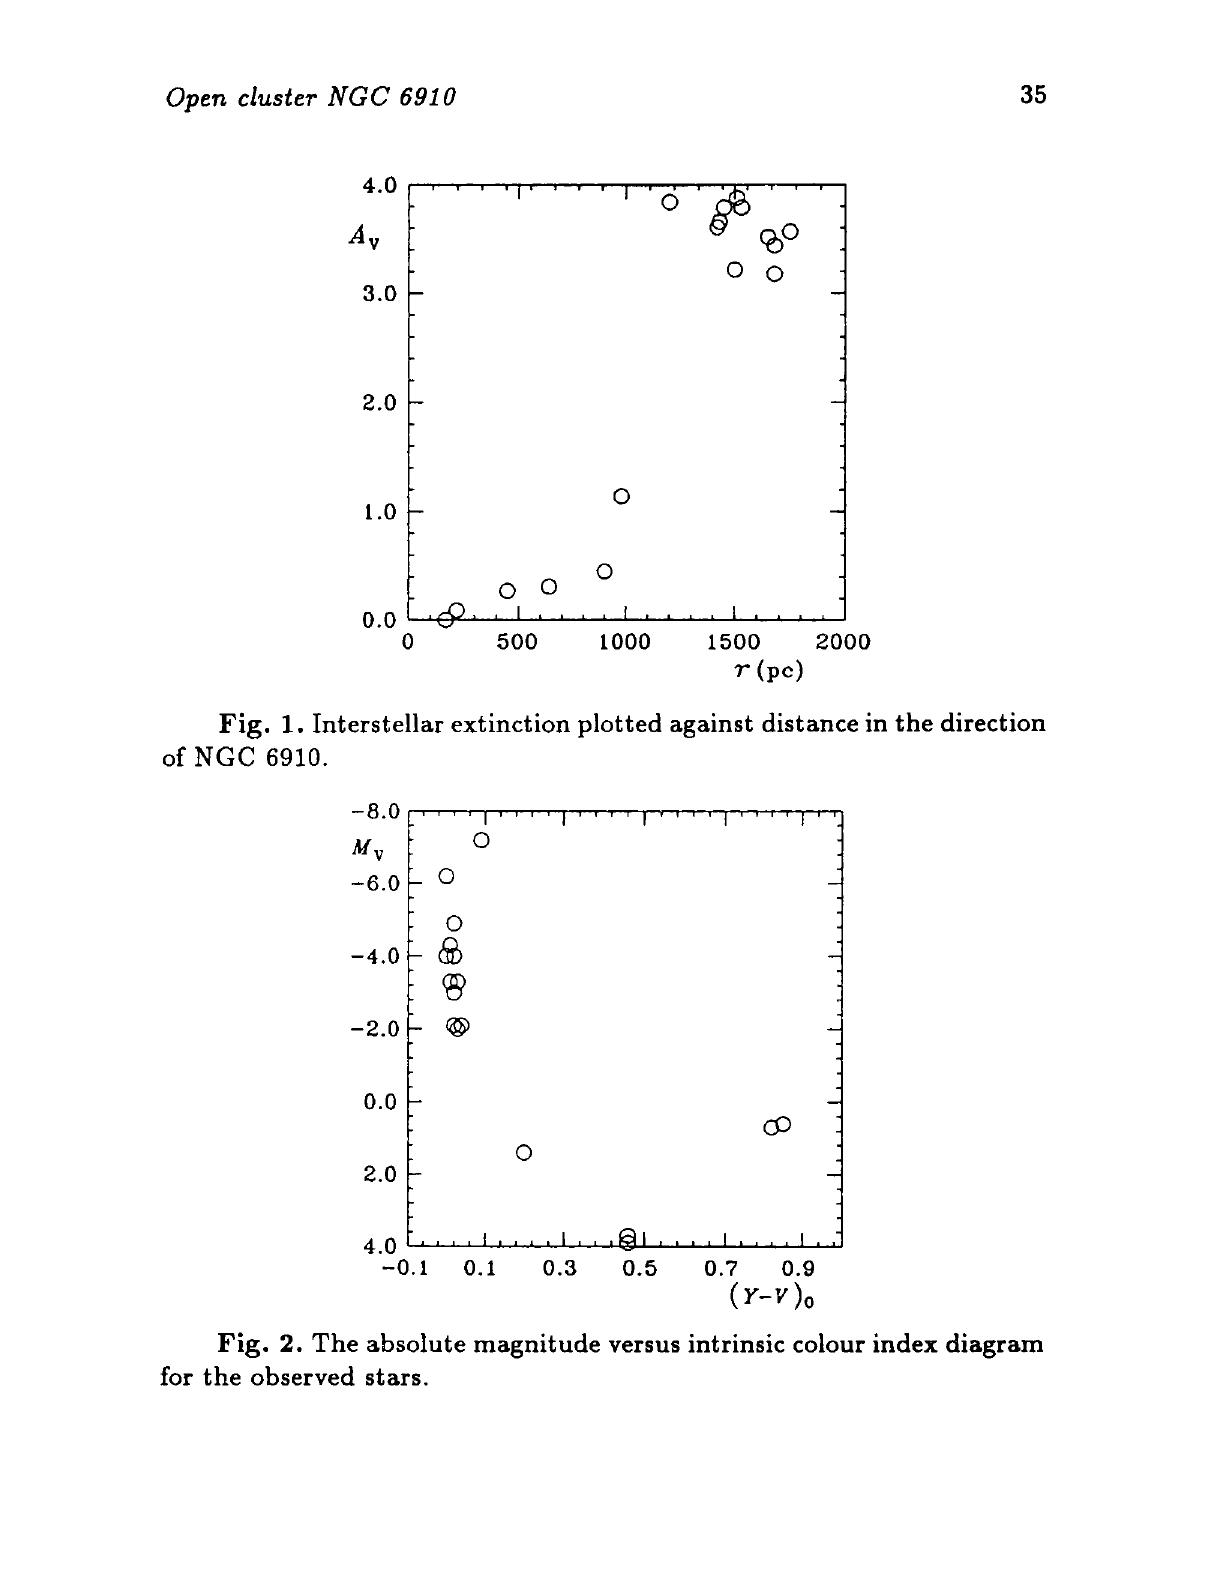
Fig. 2. The absolute magnitude versus intrinsic colour index diagram for the observed